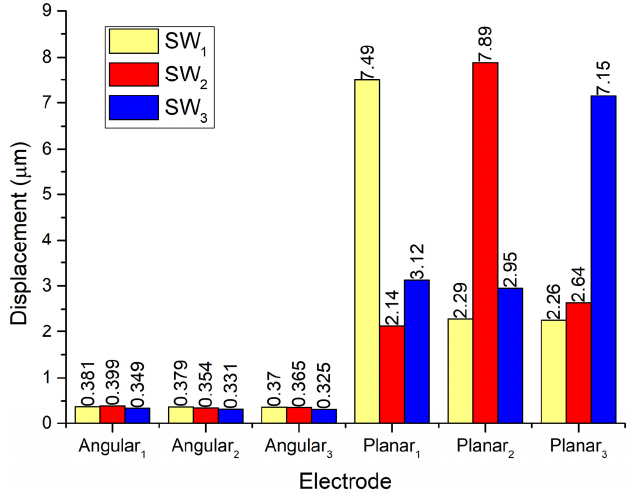
Figure 7. Comparison of displacement amplitudes while electrodes Planar 1 –Planar 3 are excited.